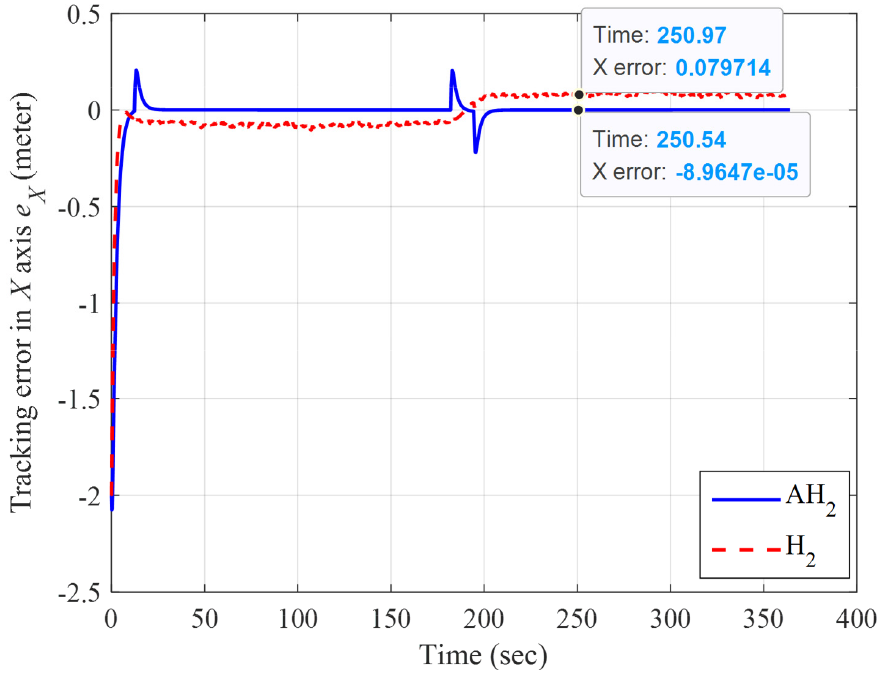
Figure 11. The square trajectory tracking error result of the adaptive H 2 closed-form and H 2 closed- form control approaches for an x- axis from x p = − 7 m, y p = − 7 m.